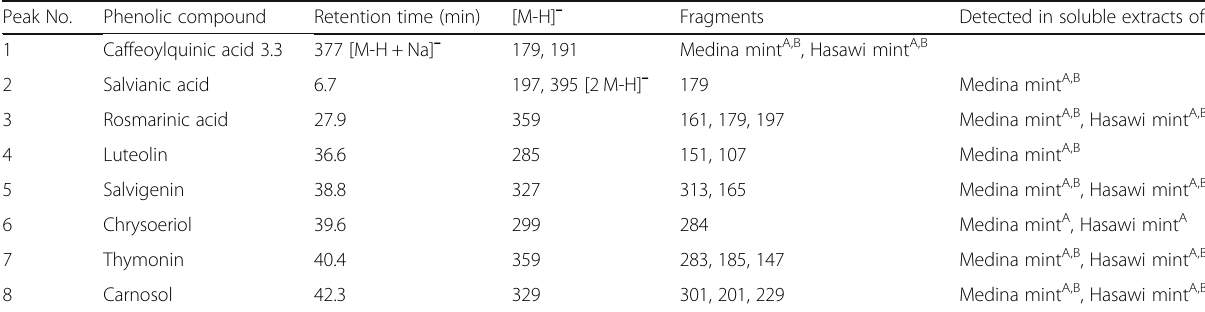
Table 4 Major phenolic compounds in mint identified using HPLC/ESI-MS/MS 1 Peak No.